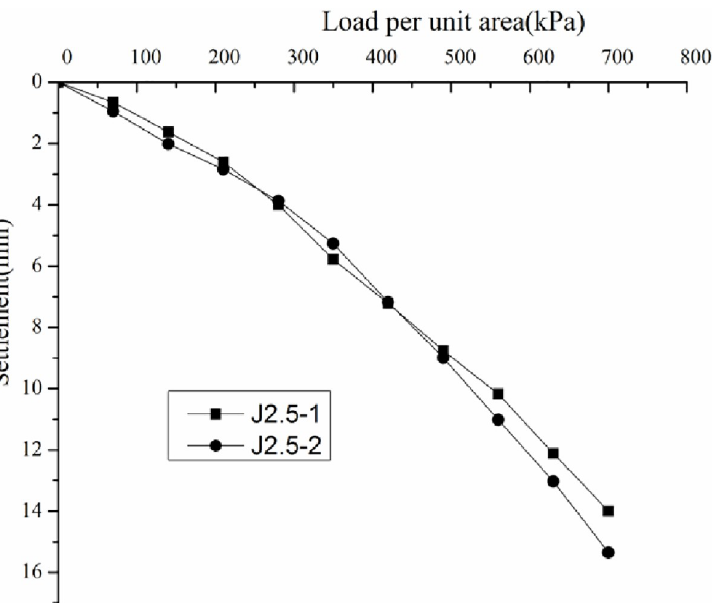
Fig 16. Load–settlement curves for the plate loading tests of